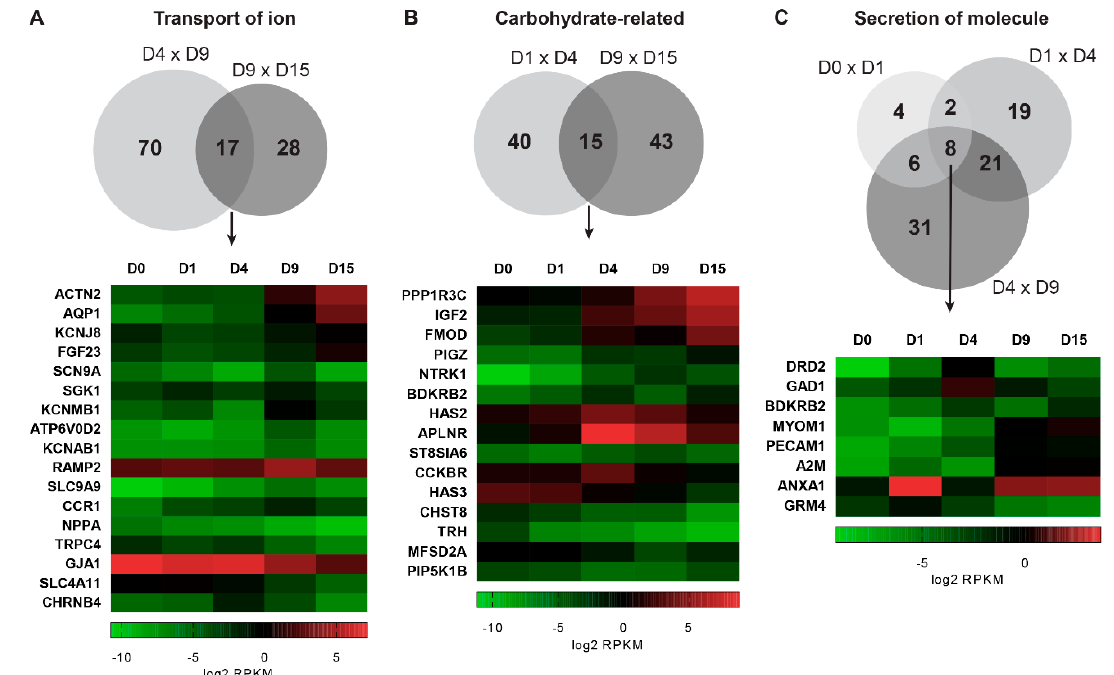
Figure 9. Biological processes that are highly regulated during in vitro cardiac differentiation. Comparison of DEGs enriched for terms related to “Transport of ion”, “Carbohydrate” and “Secretion of molecules” at different time points. Venn diagrams show the number of DEGs, and the heatmaps represent the gene expression profiles (log2 RPKM values) of common DEGs identified in each comparison.